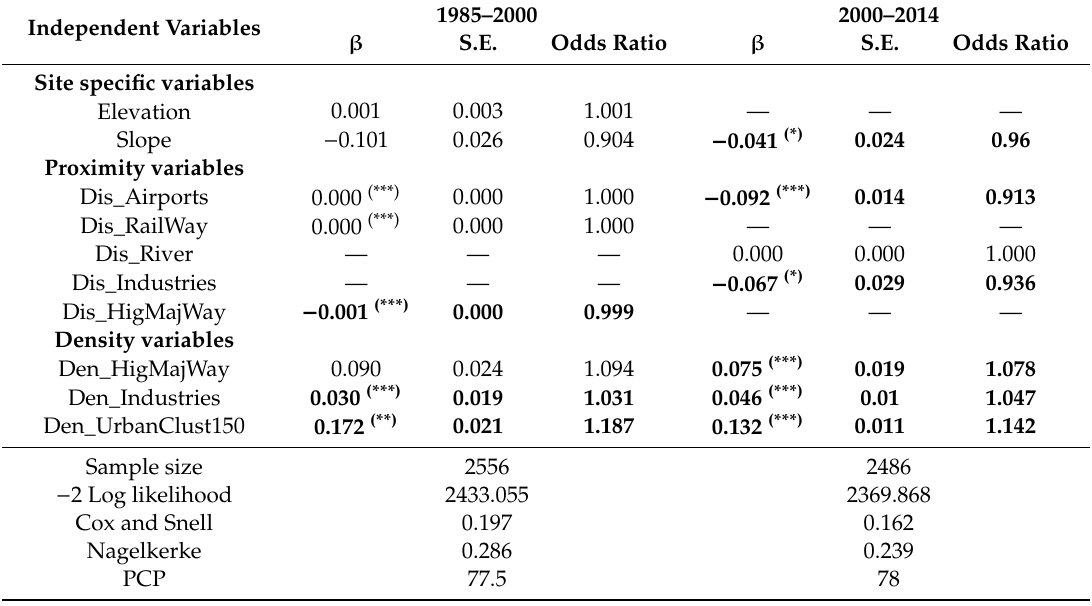
Table 2. Global logistic regression results for the probability of conversion from non-urban to urban. Independent